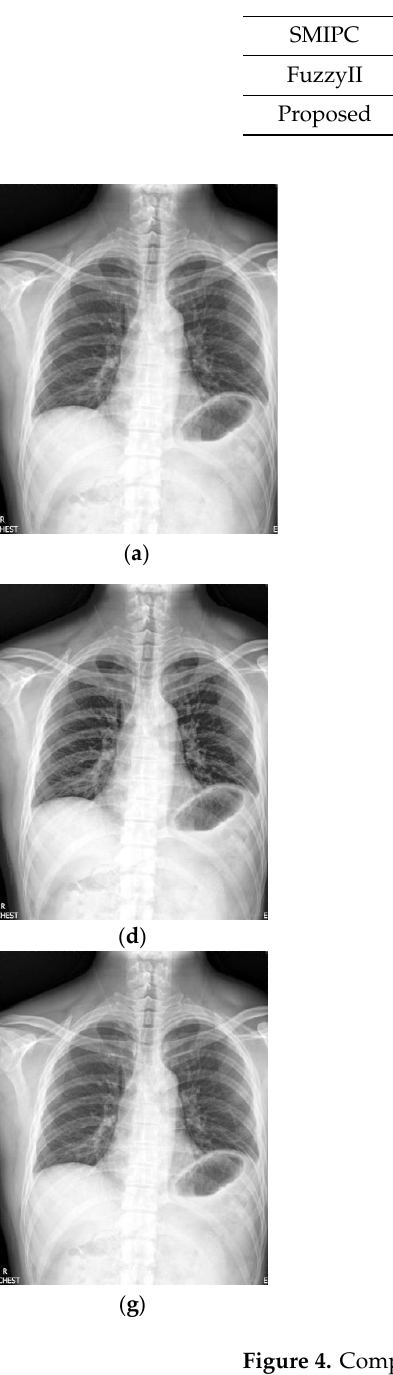
Table 4. The metric data of eight methods on X-ray image 4.